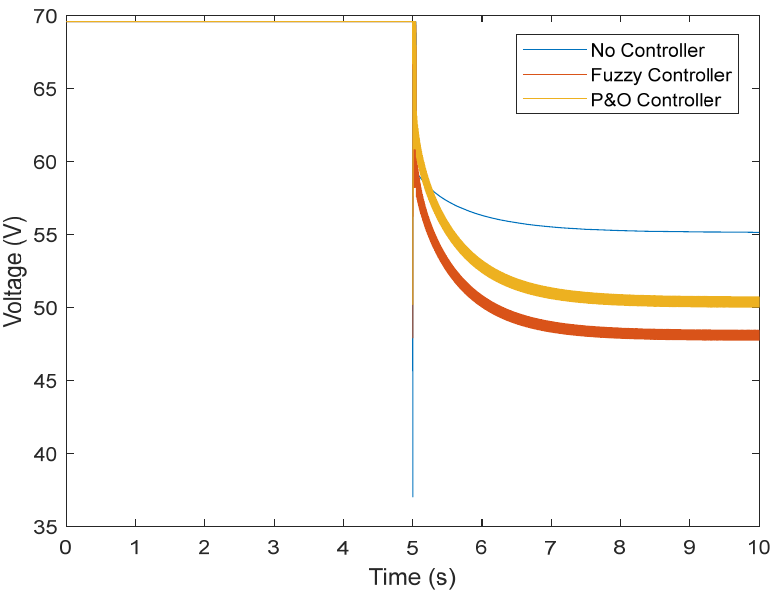
Figure 15. Output voltage of the fuel cell in the transient state.